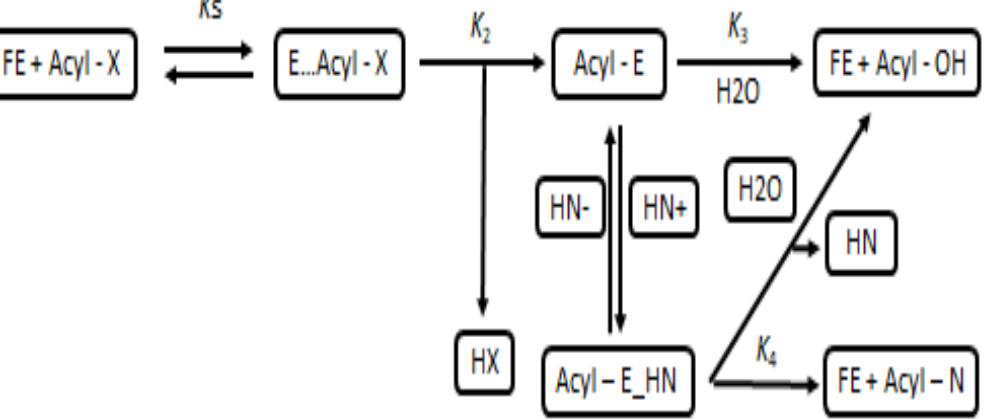
Figure 3. Kinetically control enzymatic peptide synthesis. FE: free enzyme, Acyl-X: acyl donor substrate, E., Acyl-X: acyl-enzyme complex, HX: released group, Acyl-E: acyl-enzyme intermediate, HN: nucleophiles, Acyl-N: target peptide, Acyl-OH: product of hydrolysis.